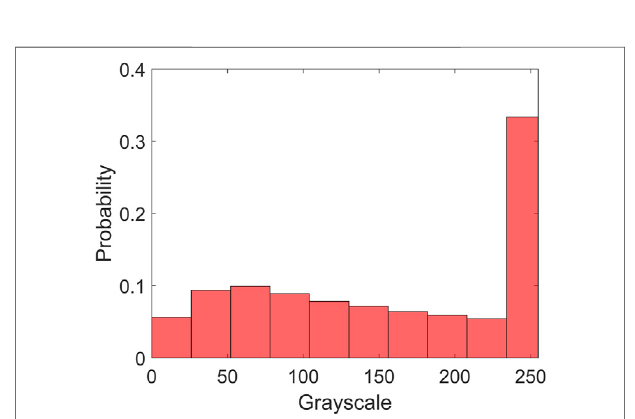
FIGURE 8 | The grayscale histogram of all the feature